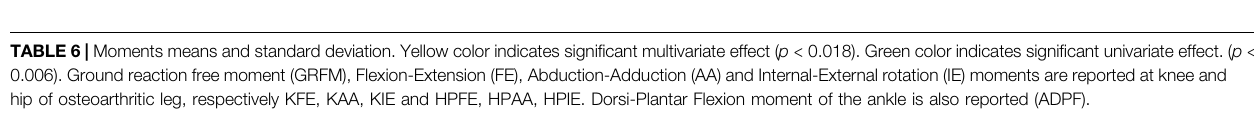
TABLE 6 | Moments means and standard deviation. Yellow color indicates signi fi cant multivariate effect ( p < 0.018). Green color indicates signi fi cant univariate effect. ( p < 0.006). Ground reaction free moment (GRFM), Flexion-Extension (FE), Abduction-Adduction (AA) and Internal-External rotation (IE) moments are reported at knee and hip of osteoarthritic leg, respectively KFE, KAA, KIE and HPFE, HPAA, HPIE. Dorsi-Plantar Flexion moment of the ankle is also reported (ADPF).